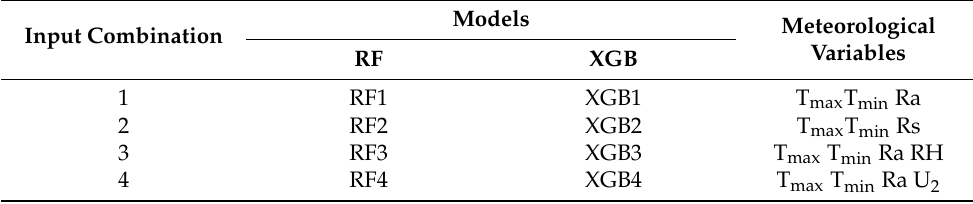
Table 2. Input combinations for the machine learning